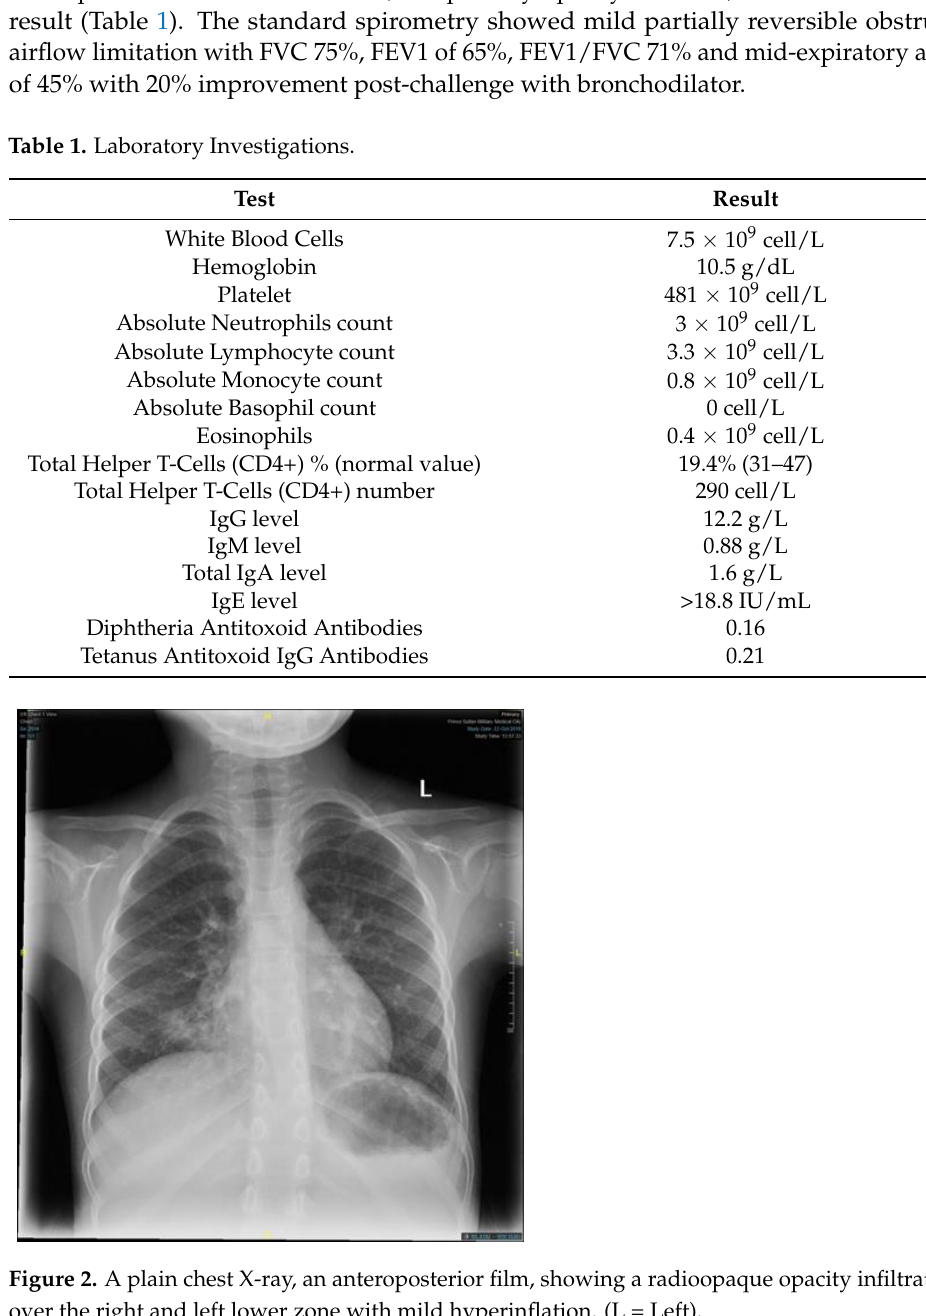
Figure 3. A chest CT scan, an axial view of lung window, showing cystic changes strongly con- sistent with bronchiectasis in lower lobes. (A = Anterior, P = Posterior, R = Right, L = Left).